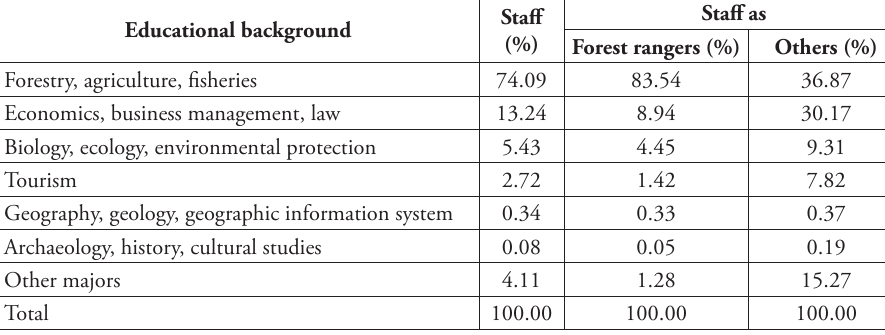
Table 7. National parks’ staff by educational background.